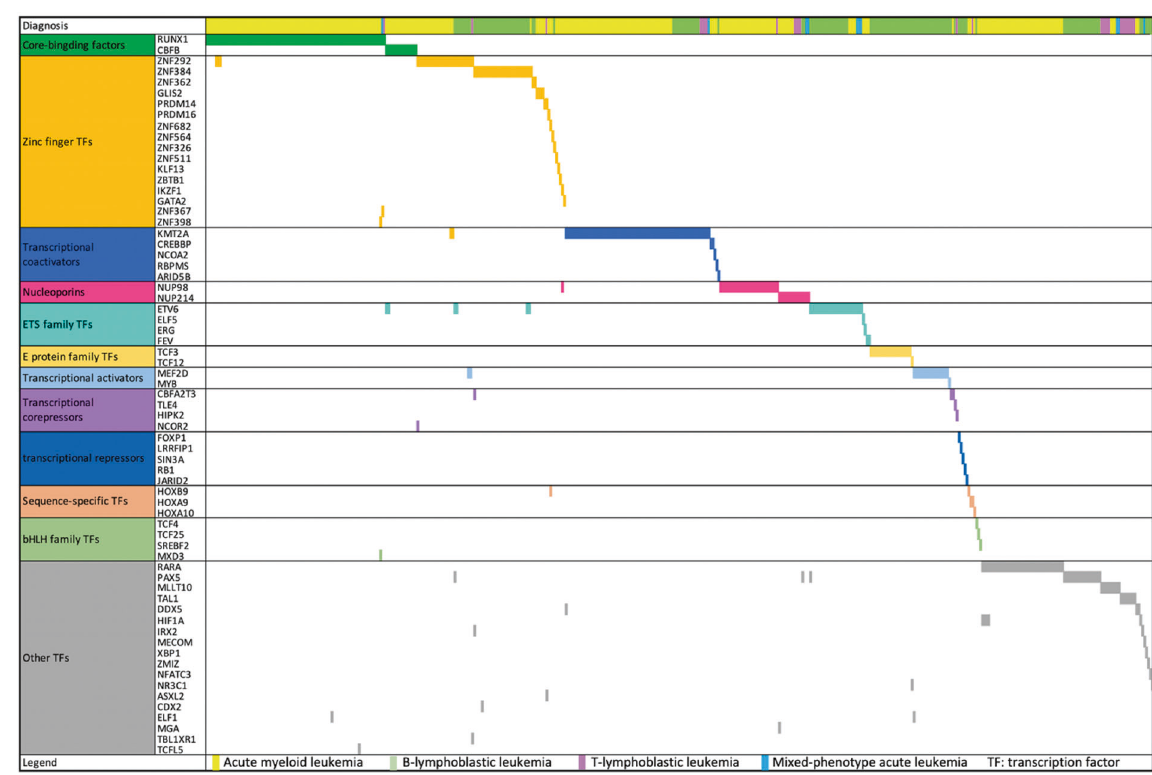
Fig. 4 The landscape of transcription factor fusions in different leukemia subtypes. The horizontal and vertical axes represent the patients and transcription factor genes, respectively. Genes were ordered based on transcription factor class. Color bar depicts the diagnosis of each sample.